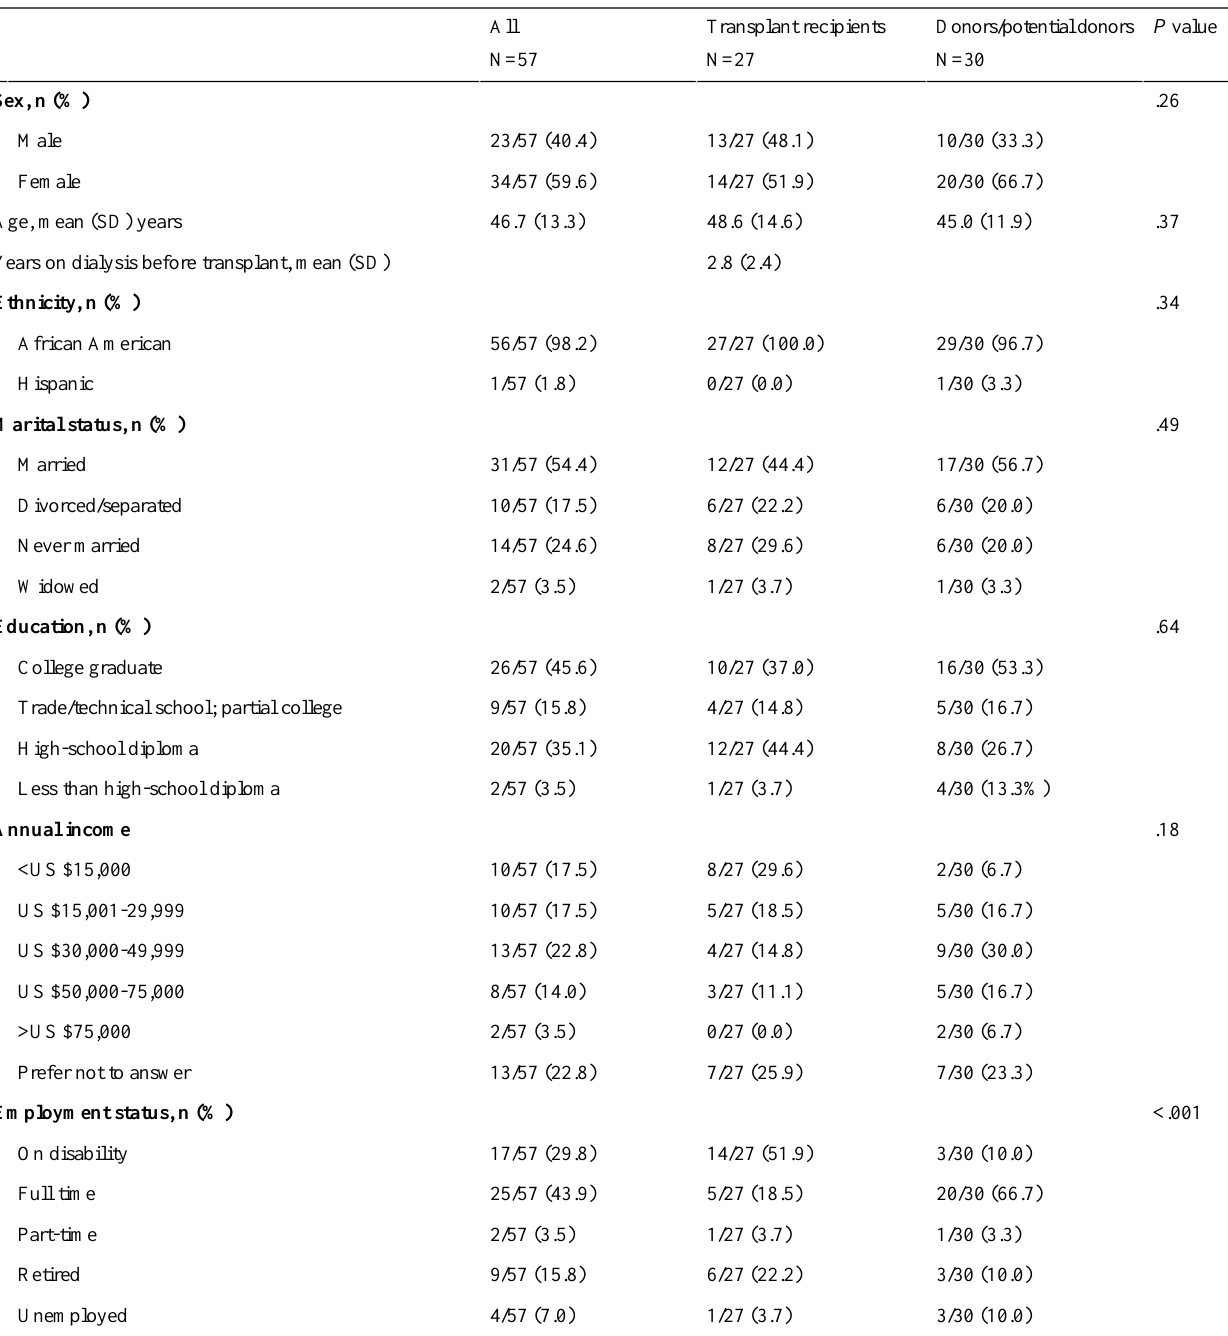
Table 1. Demographics of the